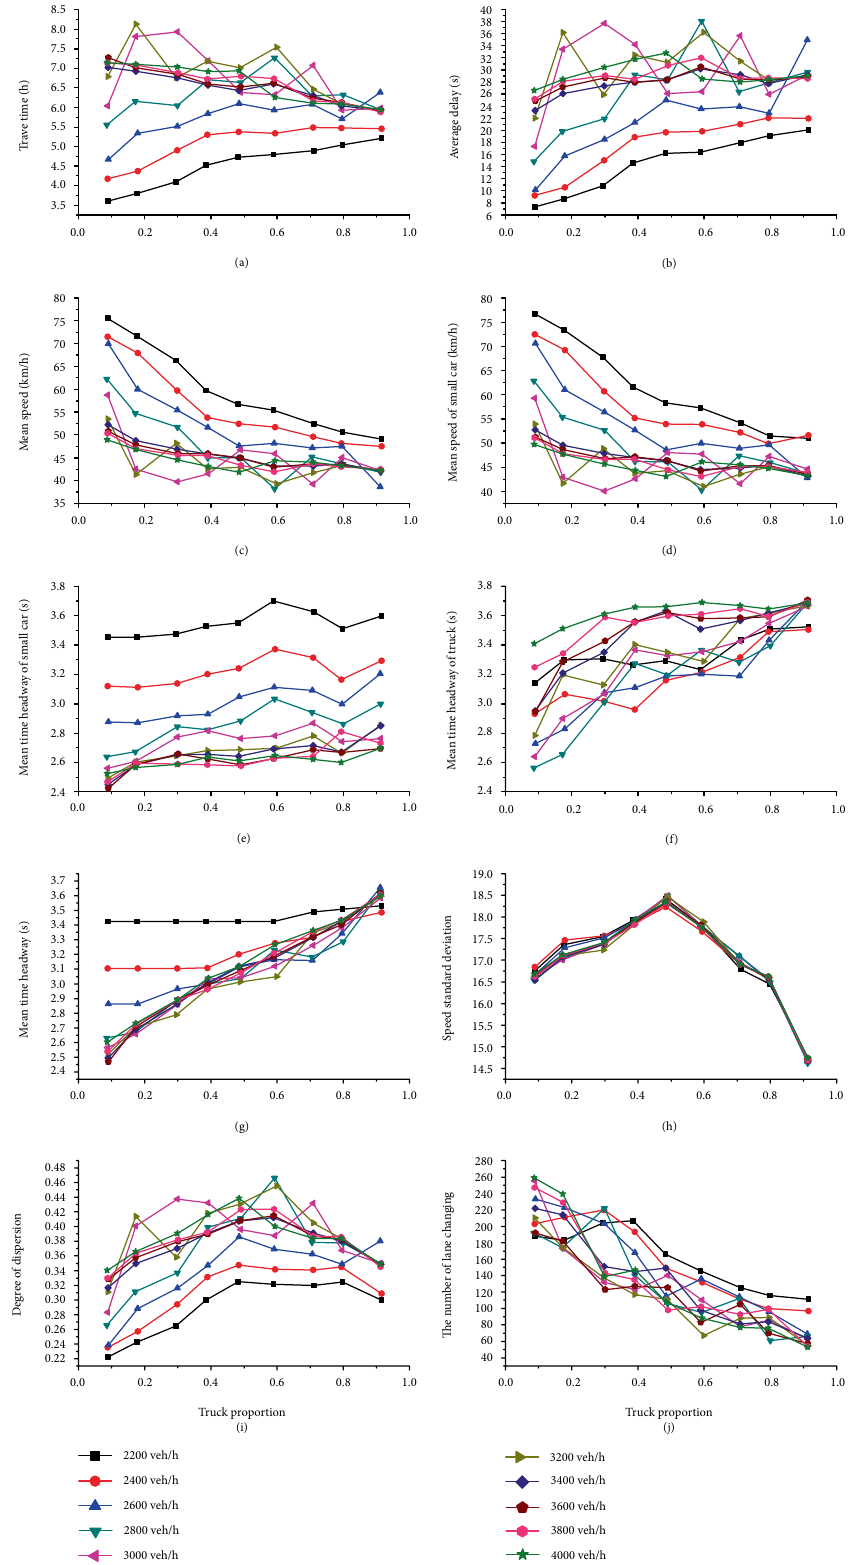
Figure 2: The relationship among truck proportion with other traffic